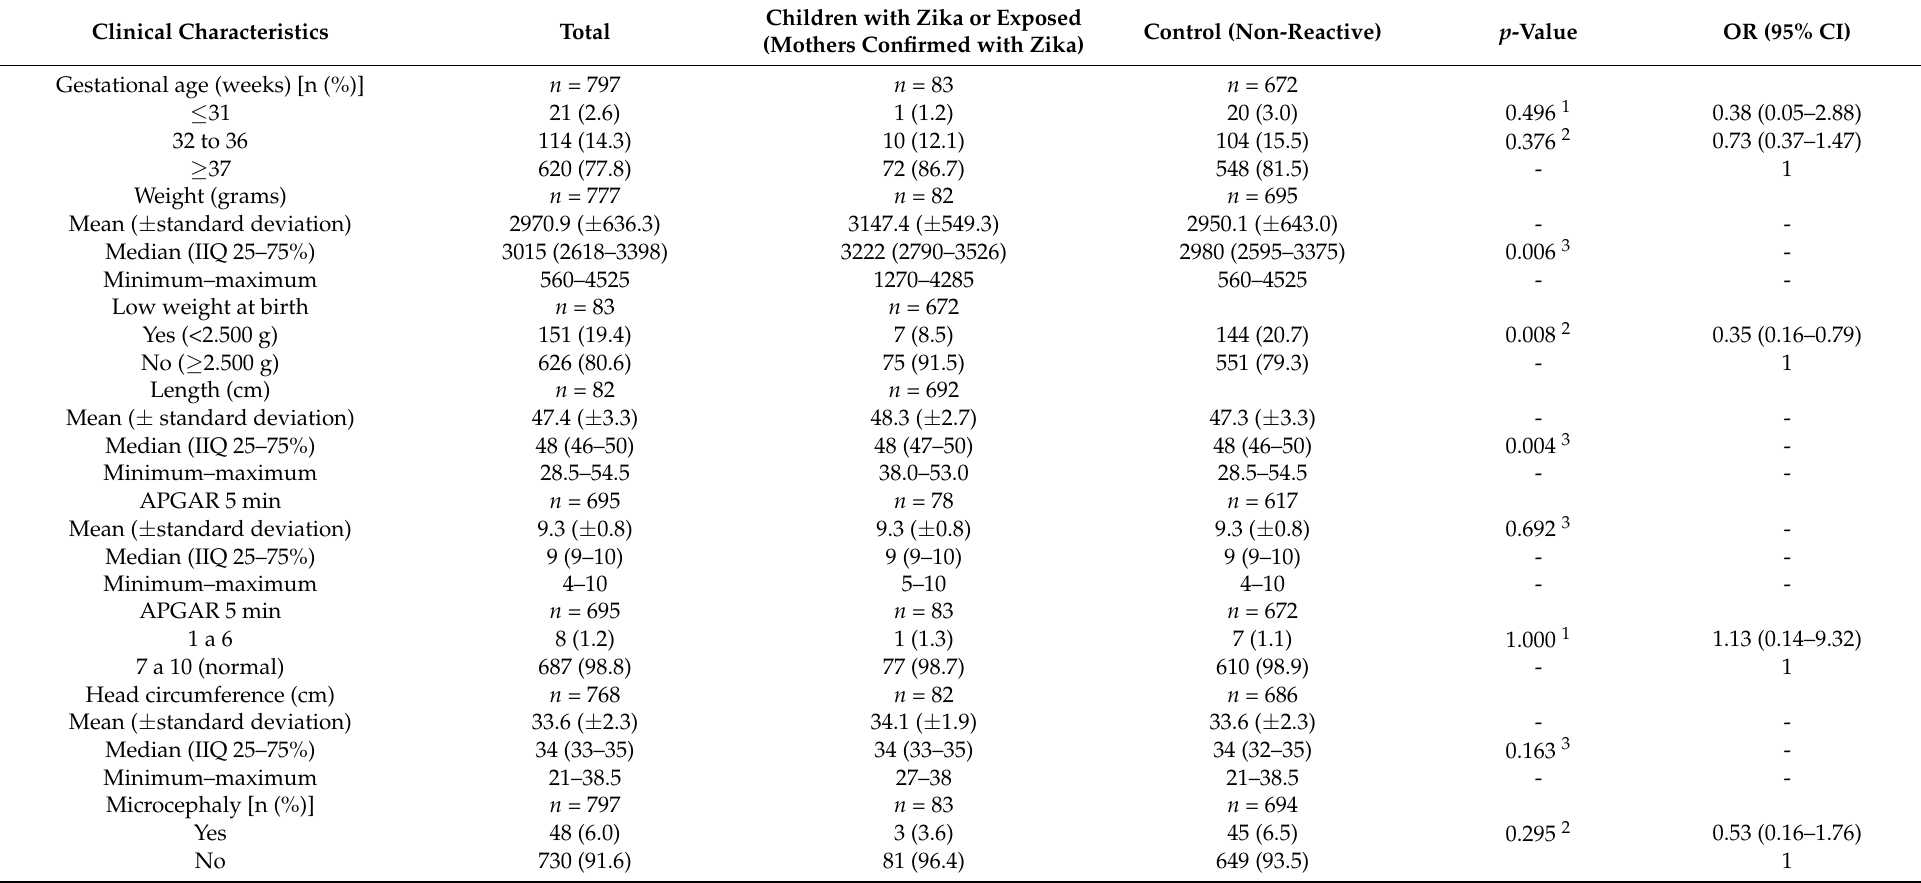
Table 2. Anthropometric characteristics of the exposed, positive, and control newborns at birth, Jundia í Medical School,